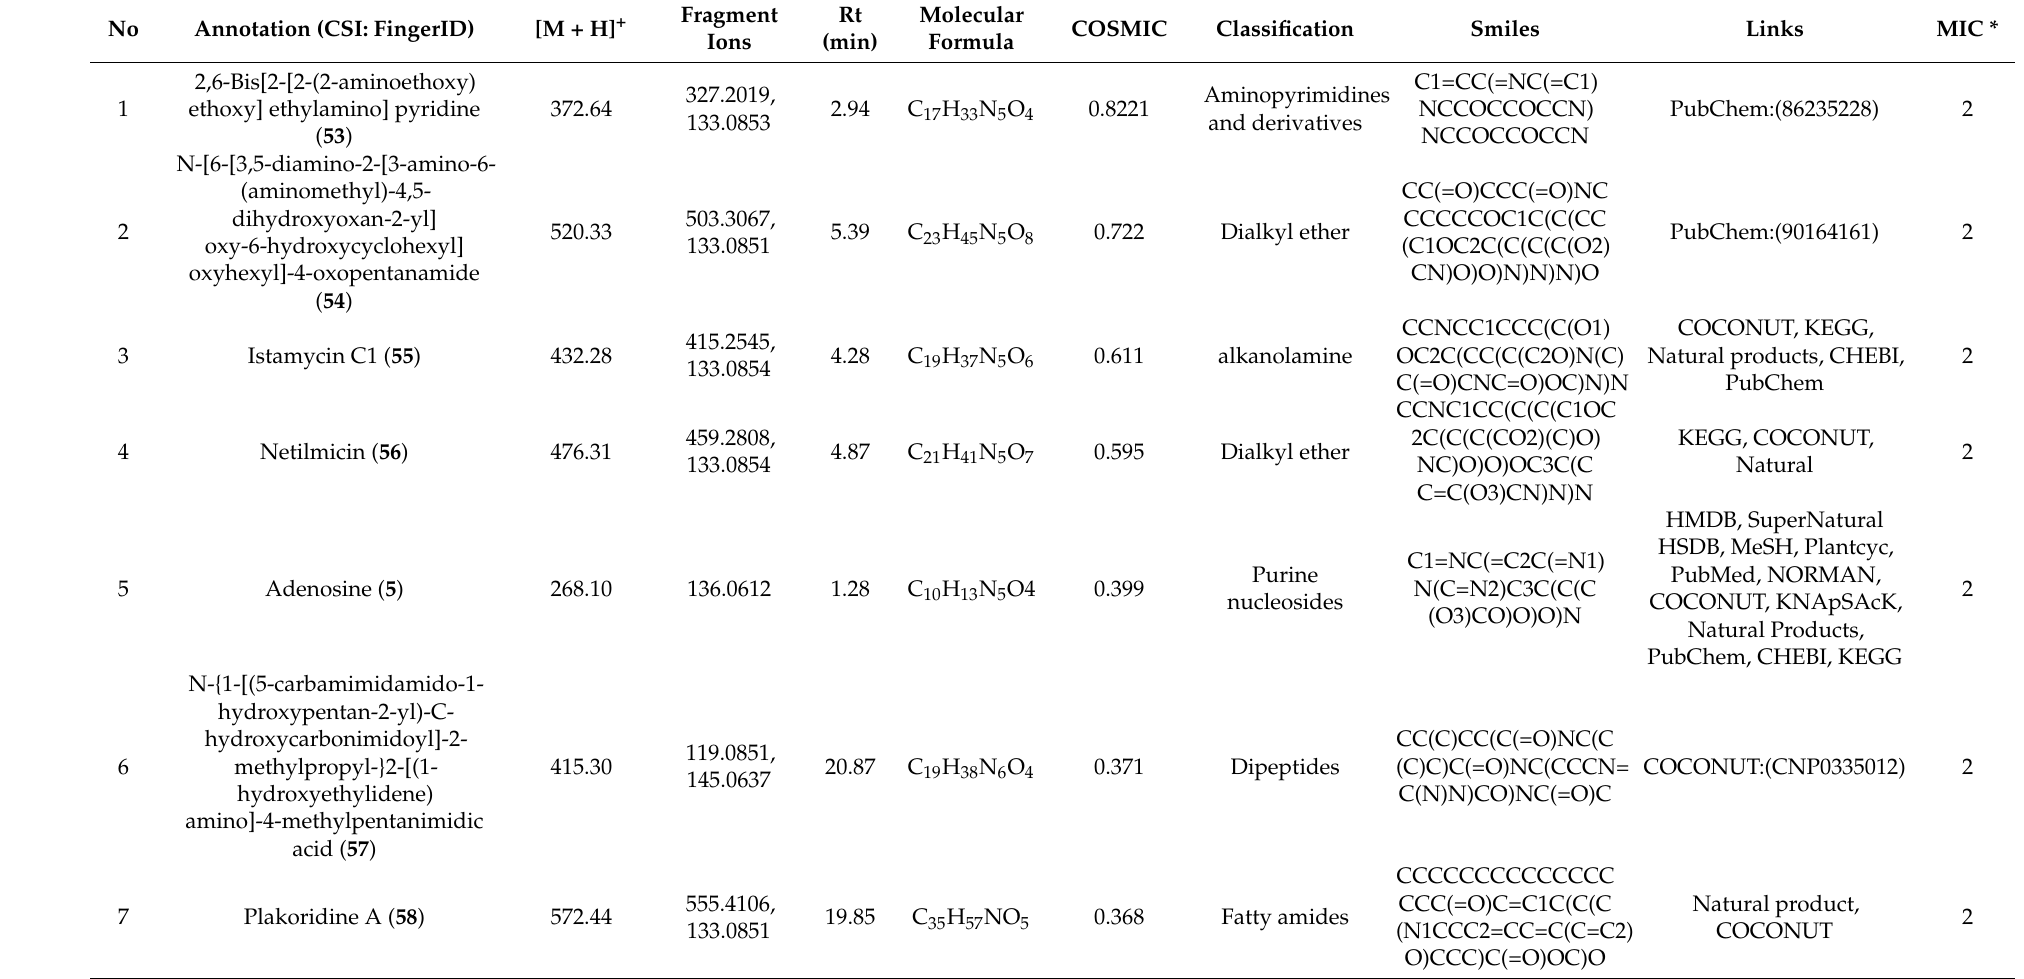
Table 4. Identified phytochemicals from SIRIUS 4.0